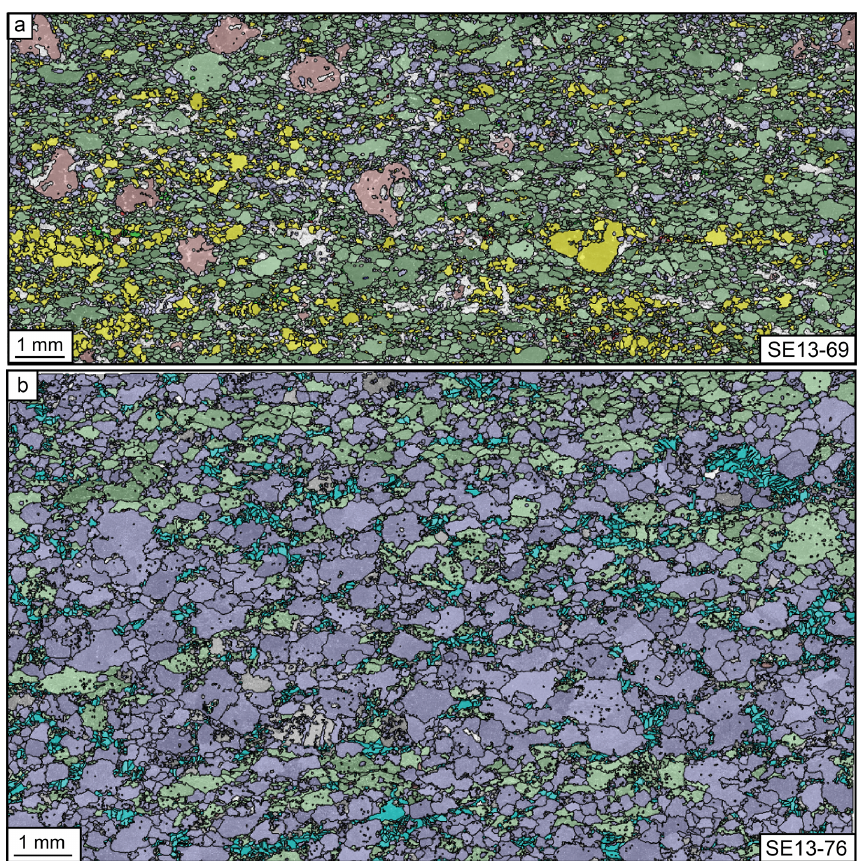
Figure 4. EBSD phase maps (a) from a slightly retrogressed, at amphibolite facies, garnet–clinopyroxene-bearing amphibolite at the top of HTa unit (sample SE13-69; Sumeini area); (b) from a highly retrogressed garnet–clinopyroxene-free amphibolite at the base of HTa unit (sample SE13-76; Sumeini